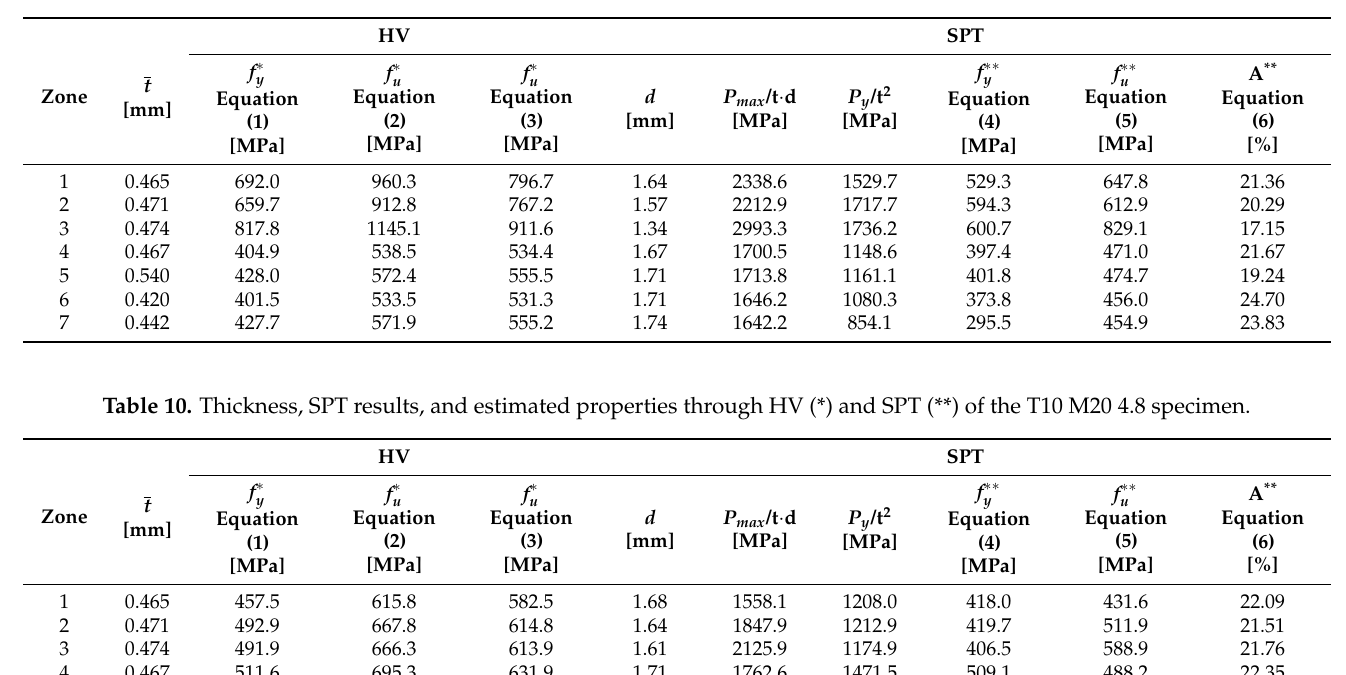
Table 9. Thickness, SPT results, and estimated properties through HV (*) and SPT (**) of the T10 M16 K800 specimen.